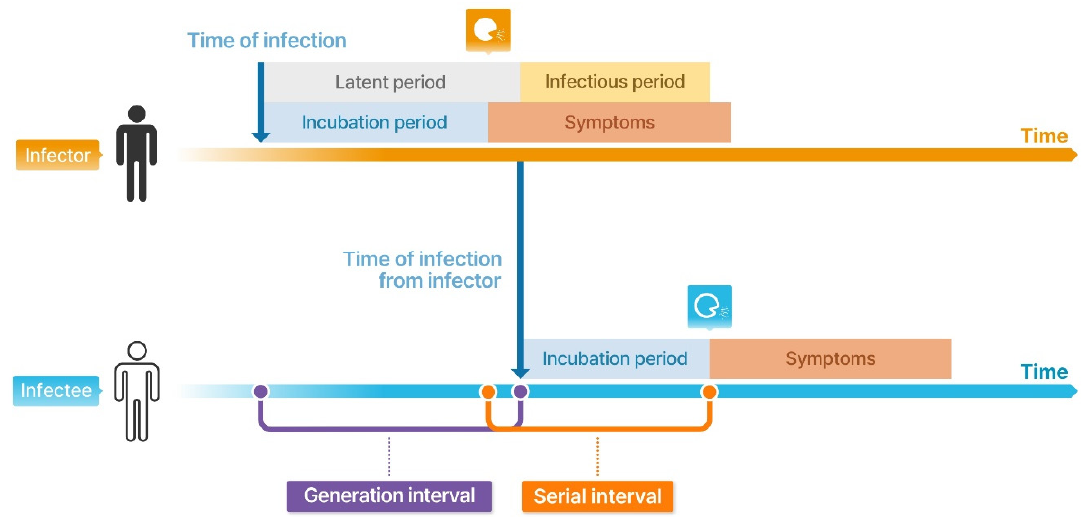
Figure 3. Schematic illustration of the generation interval and serial interval under biological and clinical processes. The latent period is the interval between the time of infection and when an individual becomes infectious, and the infectious period is the length of the time during which an individual can transmit a pathogen. The incubation period is the interval between the time of infection and the illness onset. The generation interval is the time between the infection events in successive cases in a transmission chain (i.e., between infector and infectee), and the serial interval is the time between the illness onset from infector to infectee.